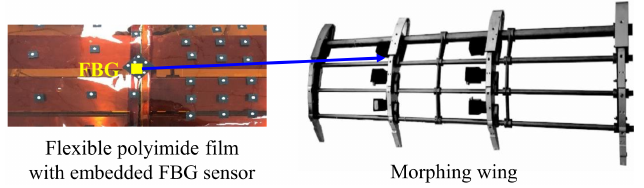
Figure 11. Polyimide FBG sensor in the morphing wing of an